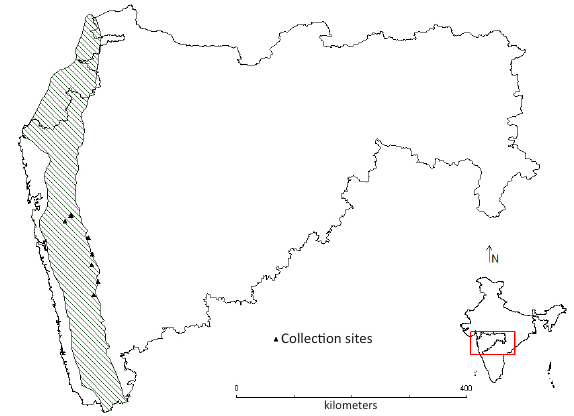
Figure 1. Collection localities in Maharashtra.